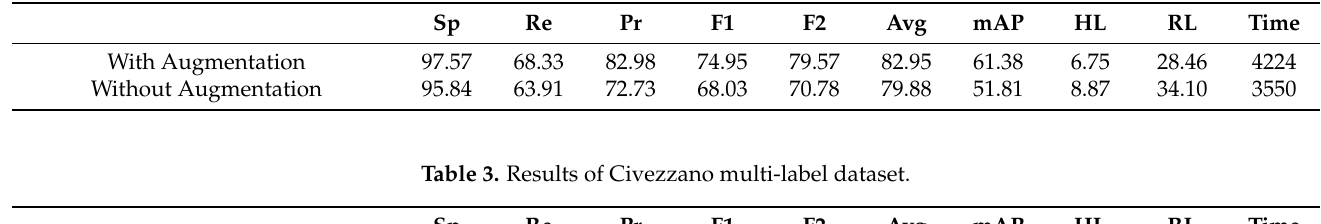
Table 2. Results of Trento multi-label dataset.